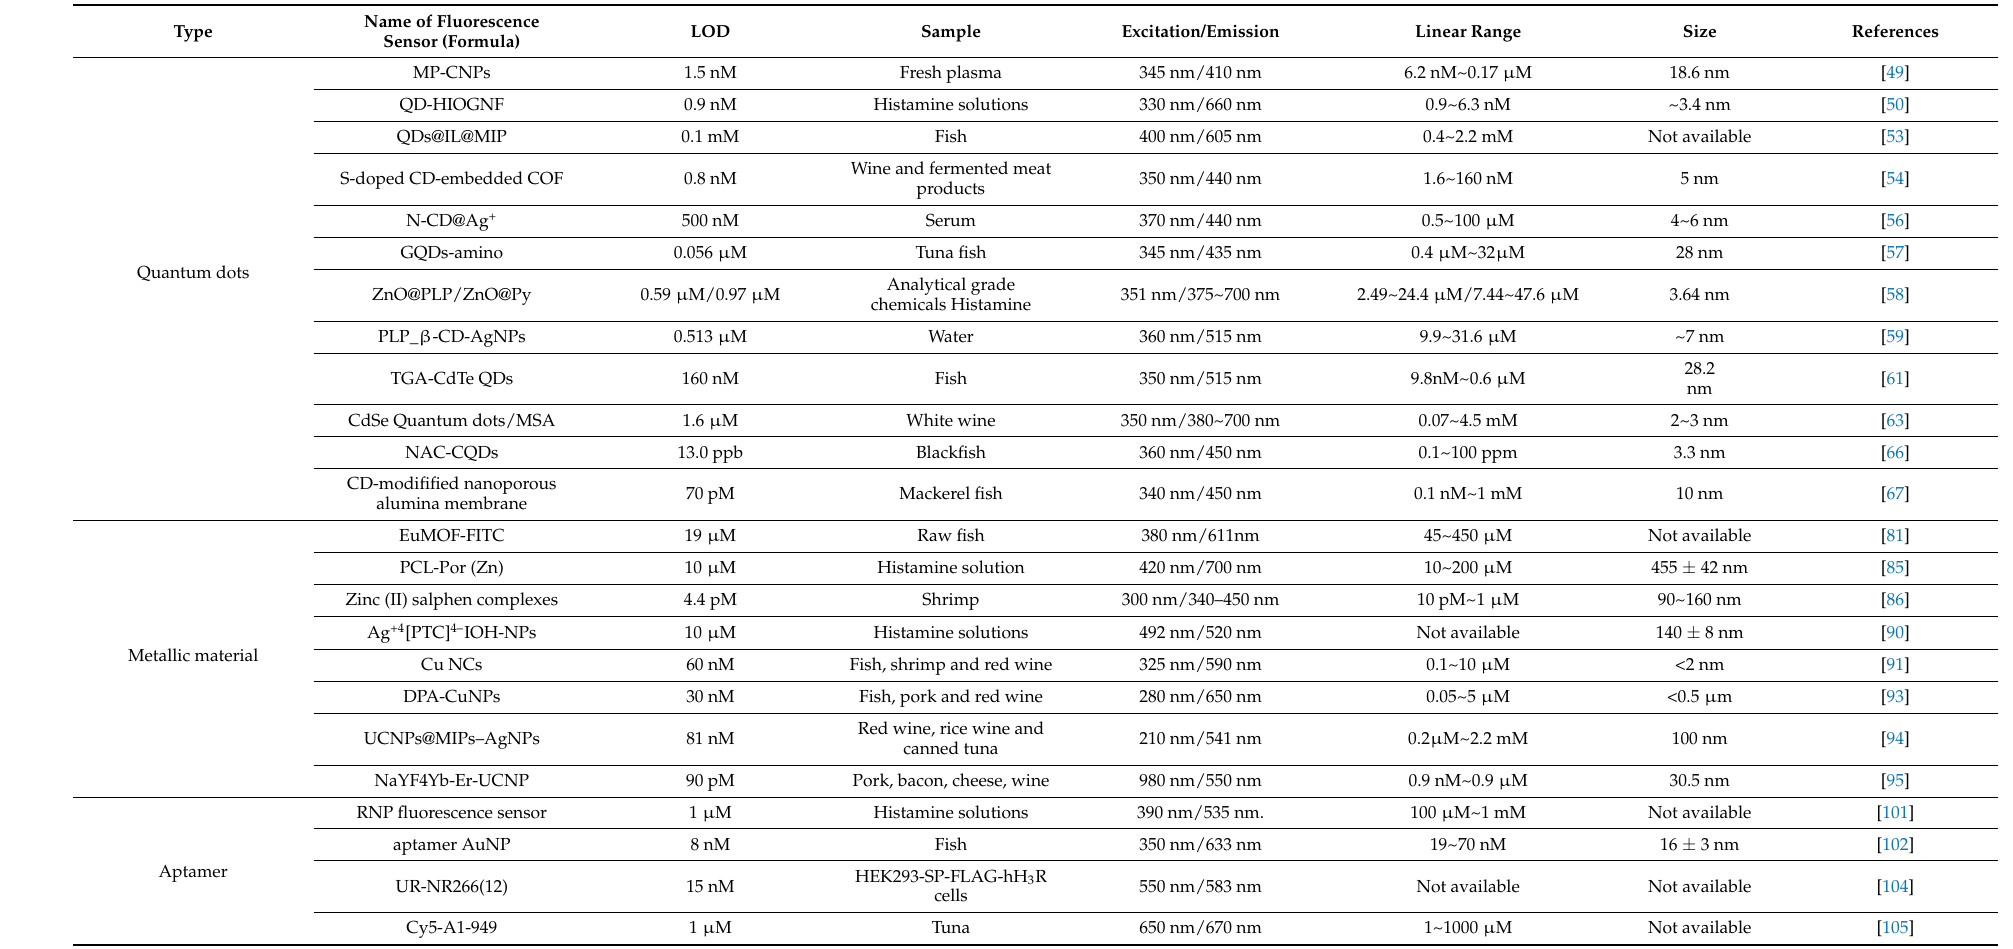
Table 1. Summary of representative examples of fluorescence sensors for the detection of histamine in